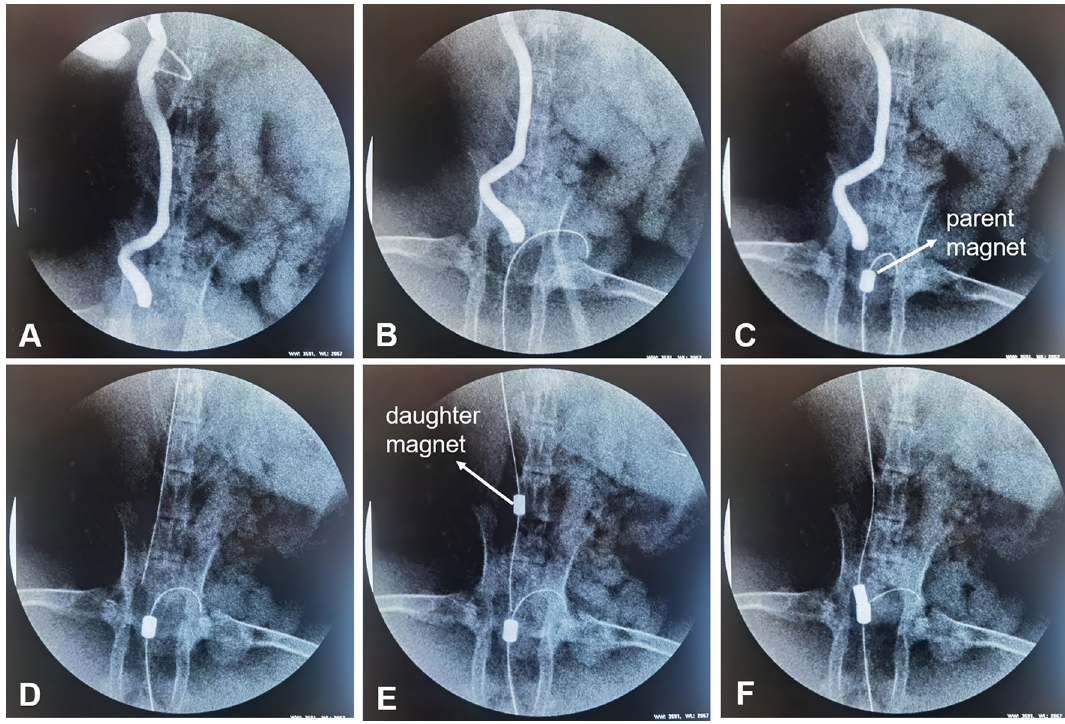
Figure 3. Representative intraoperative images. ( A ) Right ureterography showed distal ureteral obstruction. ( B ) The guide wire is passed through the urethra into the bladder. ( C ) The parent magnet is inserted into the bladder along the guide wire. ( D ) Guide wire into the right ureter. ( E ) The daughter magnet is inserted into the right ureter along the guide wire. ( F ) The parent and daughter magnets are attracted together.